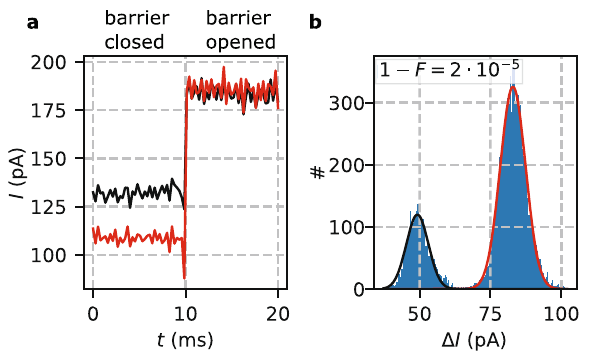
Fig. 5 Fidelity F of single-shot charge-readout at the ends of the shuttle device. a SET current trace I during the two stages of the detection segment with an electron present (red) and without an electron (black) at the end of the one-dimensional QuBus channel. During the fi rst 10 ms, the tunnel barrier between the 1DEC and the SET is fully opaque and then fully transparent during the second 10 ms allowing an electron potentially present to immediately leave the 1DEC. b Histogram of the current steps Δ I between the two detection stages in a for 11,300 traces with arbitrary charge state 0 or 1 at the end of the channel before the start of the detection segment. The events covered by the two fi tted Gaussians are assigned to the electron occupation 0 and 1 (red and black Gaussian fi t),